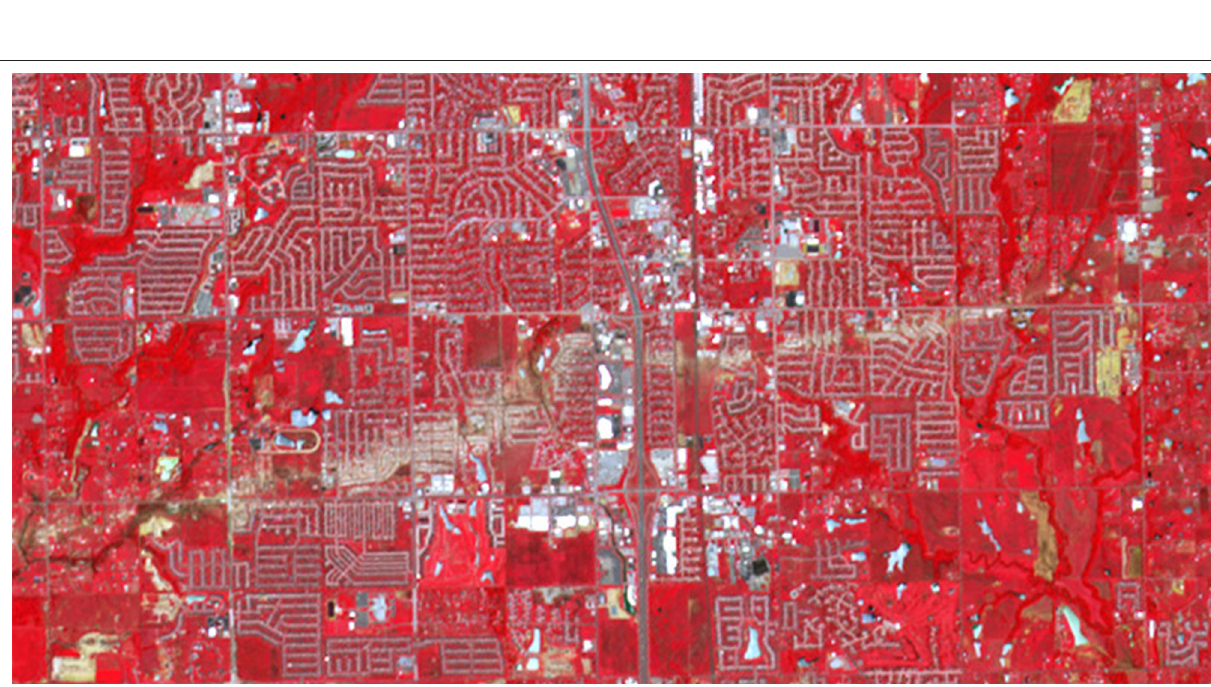
Frontiers in Built Environment | www.frontiersin.org